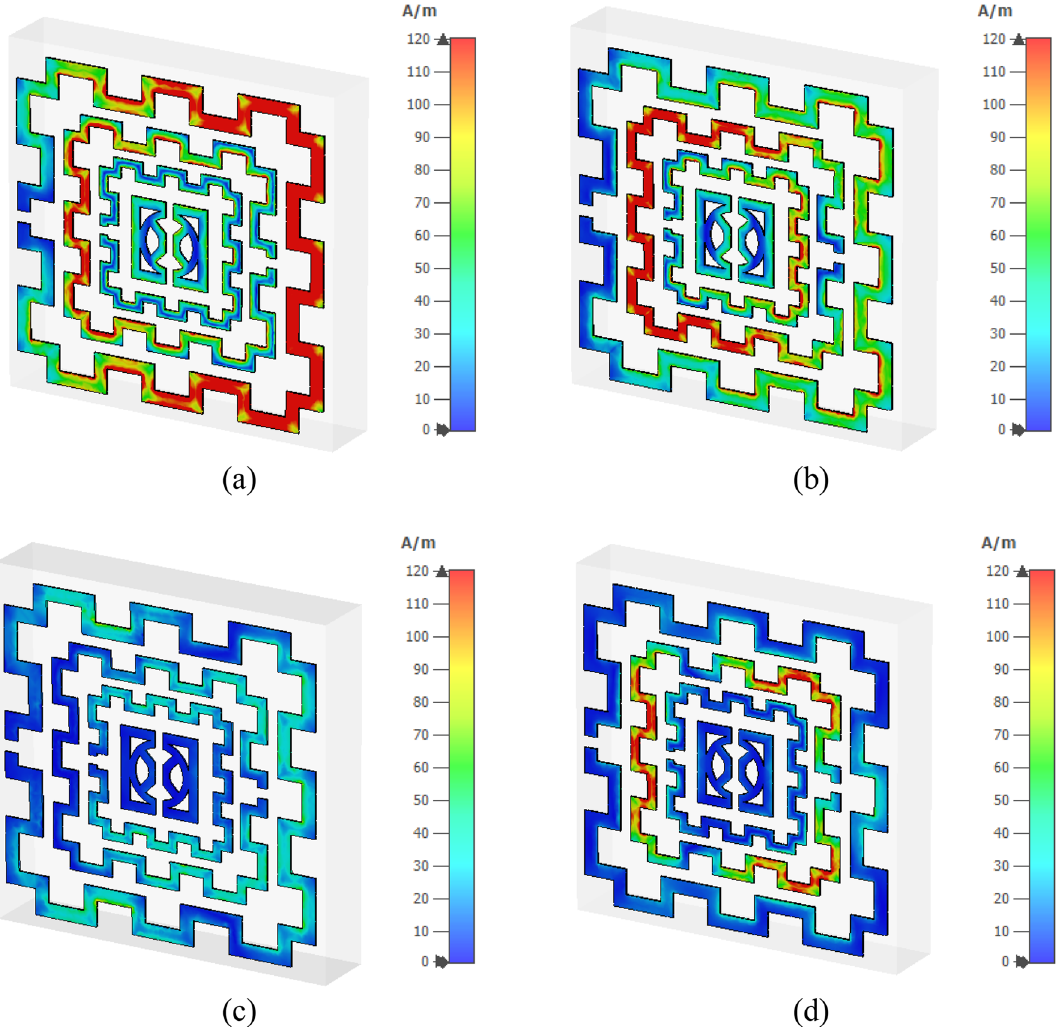
Figure 12. Magnetic field distribution ( a ) 2.48 GHz ( b ) 4.28 GHz ( c ) 9.36 GHz ( d ) 13.70 GHz. (CST STUDIO SUITE 2019, https:// www. 3ds. com/ produ cts- servi ces/ simul ia/ produ cts/ cst- studio- suite) 28